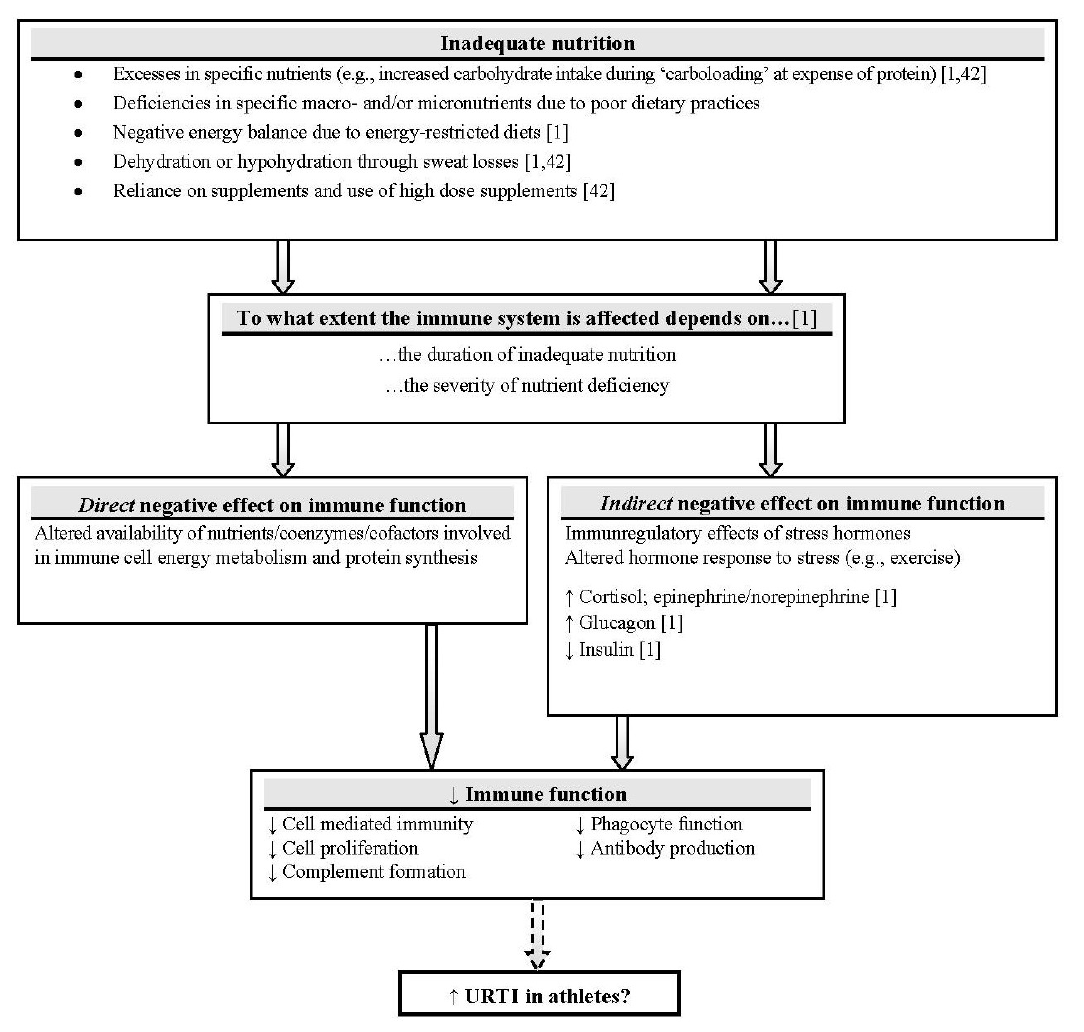
Figure 1. Nutrient availability and immune function: direct and indirect mechanisms. It can be inferred that a poor nutrition state may exacerbate cellular immune responses to heavy exercise and further impair immune function [47]. Adapted with permission from Walsh [32] (Solid arrows: research evidence mostly supports link; dashed arrow: limited research evidence to support link in athletes; ↑: increase; ↓: